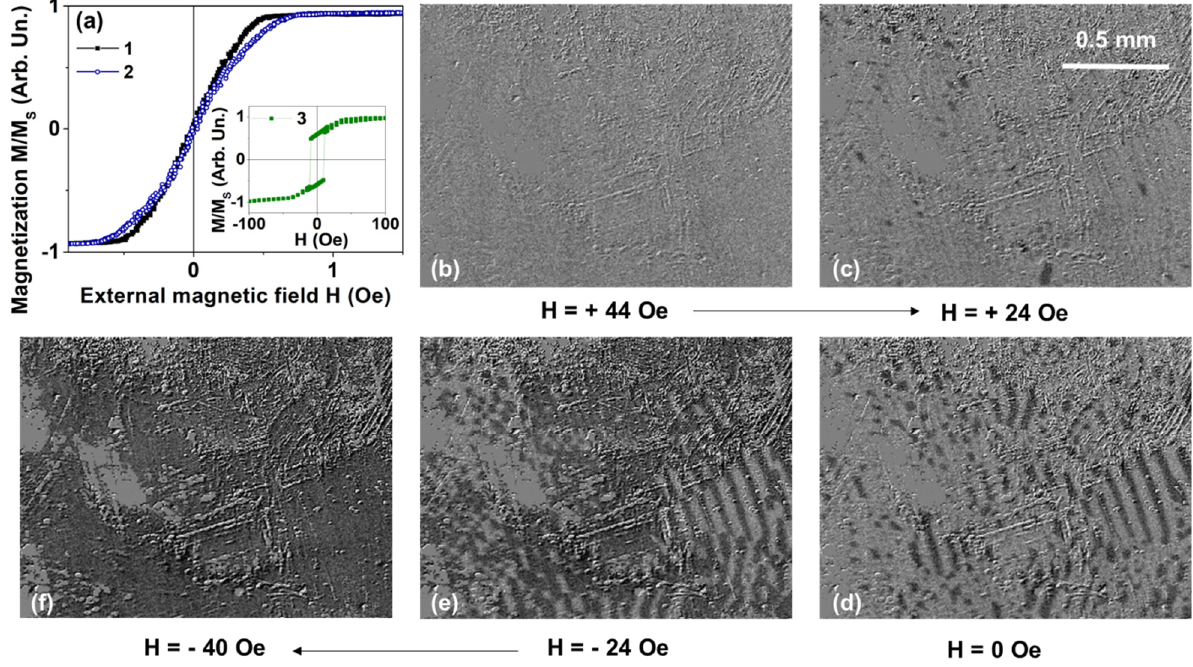
Figure 2. ( a ) Magnetoinductive magnetic hysteresis loops for the magnetic field applied in-plane of the ribbon and along the long side of it: (1)—the IR sample; (2)—the R-FeNi sample; and MOKE hysteresis loop (3)—Fe 20 Ni 80 film 1 µ m thick. ( b – f ) Magnetic domains of Co 67 Fe 3 Cr 3 Si 15 B 12 IR-samples starting from magnetic saturation state in the high positive magnetic